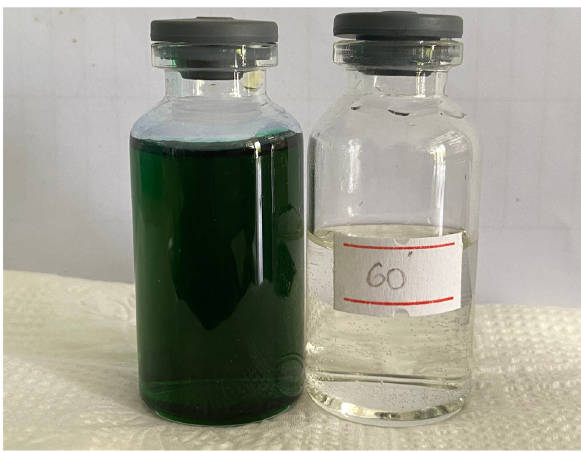
Figure 8: Mixture of MO 50 ppm and MB 40 ppm before and after degradation by Fenton - like reaction with CuCo - ZIFs. Catalyst dosage = 150mg · L − 1 , [ H 2 O 2 ] = 0.3mol · L − 1 , initial [ dye mixture ] = 20mg · L − 1 , time = 60min, and ambient temperature.